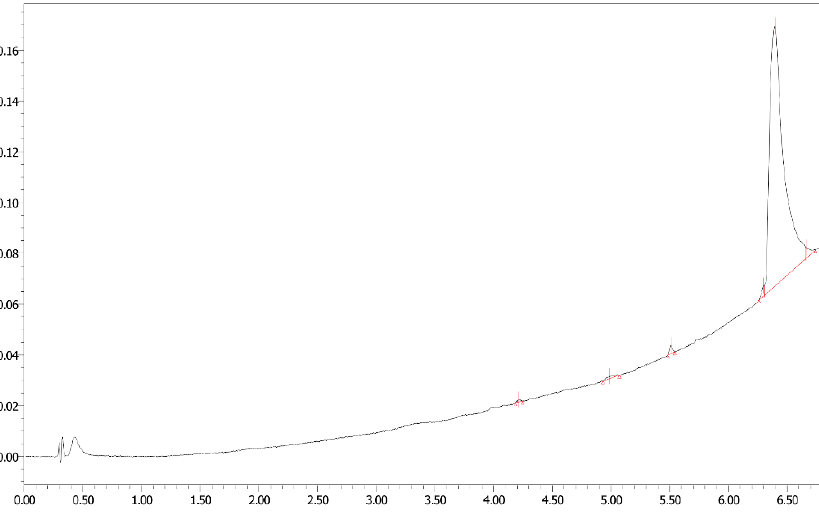
flow rate of 0.5 mL/min (95/5 to 20/80 over 7 min). The yield was greater than 64%, and PBL purities were > 96% (Figure 1).